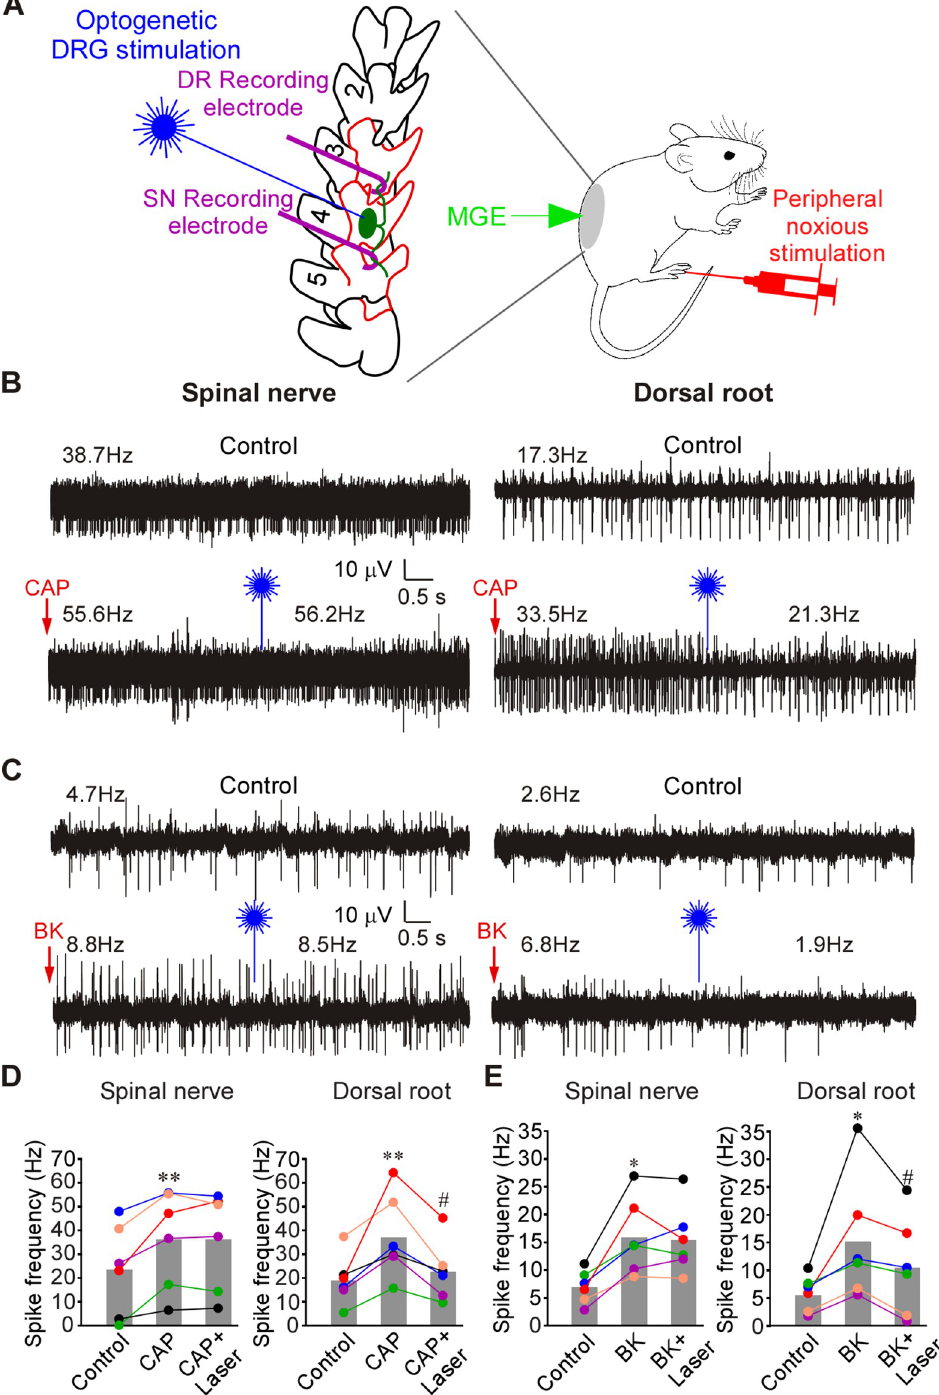
Fig 4. Optogenetic activation of MGE cells in DRG reduces frequency of firing induced by CAP or BK in the DR but not in the SN. ( A ) Schematic of the recording paradigm: mice were DRG-transplanted with VGAT-ChR2-eYFP MGE cells 3–4 weeks before recordings; recordings were done as shown in Fig 1B (but from L4 DRG), supplemented with optical stimulation of the exposed DRG. ( B ) Hindpaw injection of CAP (10 μ M, 20 μ l; indicated by red arrow) increased firing frequency in both SN and DR. Application of 473 nm laser light to DRG (indicated by blue symbol) acutely reduced CAP-induced firing frequency in DR but not SN (bottom traces). ( C ) Experiment similar to A, but BK (100 μ M, 20 μ l) was hindpaw injected, instead of CAP. ( D ) Summary of panel B. Two-factor (nerve site, drug application) repeated measures ANOVA: main effect associated with drug treatment [F(2,9) = 11.4; p < 0.05]